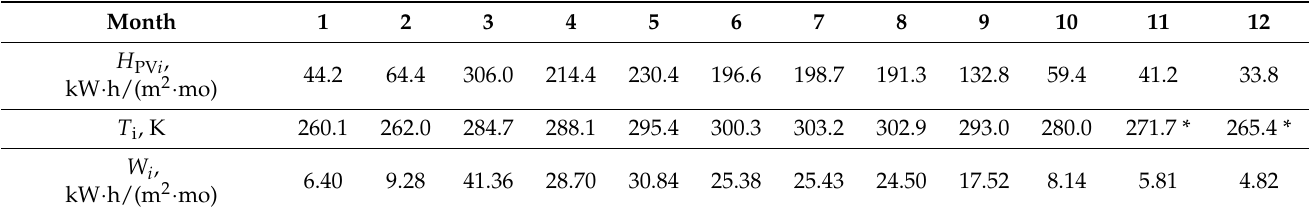
Table 9. Total monthly solar irradiation H t i , operating temperature of PV cells T i and generation W i by PV systems based on traditional planar silicon PV modules with inclination of module active surfaces at the angle β opt .